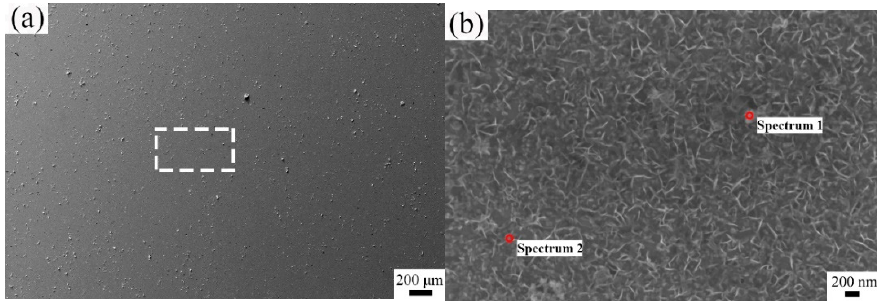
Figure 4. ( a ) SEM images of the corrosion scales of L245N standard steel and ( b ) the enlarged image of the selected area marked in ( a ) after 1/2 day of testing. Table 3. EDS results of corrosion scale formed on L245N standard steel after 1/2 day corrosion test, (at. %). The spectrum labels correspond to Figure